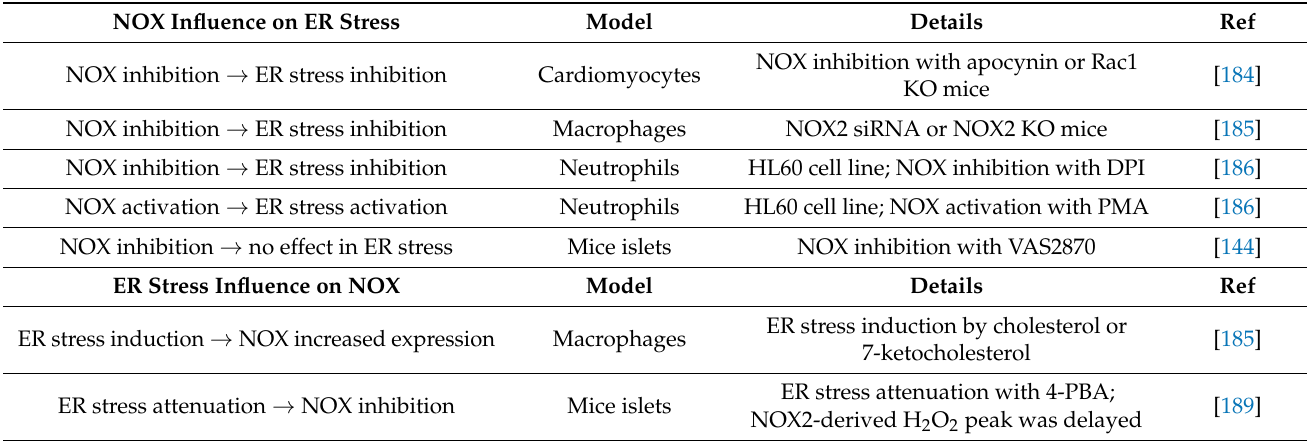
Table 1. Examples of studies involving NOX and ER stress crosstalk in different tissues.